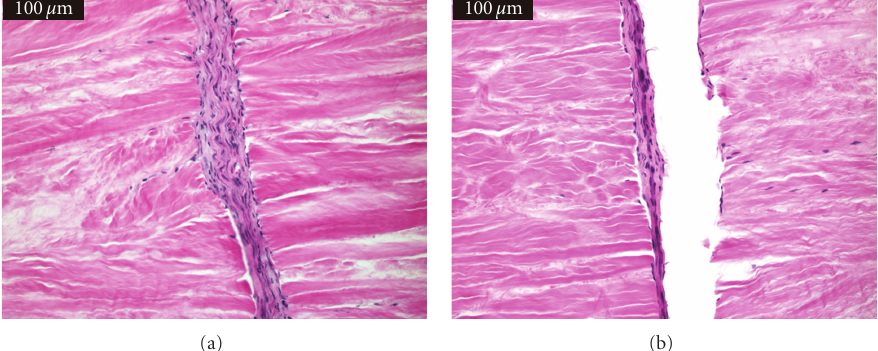
Figure 3: (a) A cell-treated (Group 1) meniscal section with cellular repopulation of the acellular meniscal tissue and evidence of bridging between the two meniscal sections, especially in the upper aspect of the image. (b) A non-cell-treated section (Group 0) with separation of the repair tissue from the meniscal fibers on the right-hand side (indicative of a less robust attachment). While this detachment occurred during processing, a lack of bonding can be seen on the left side of the repair tissue as